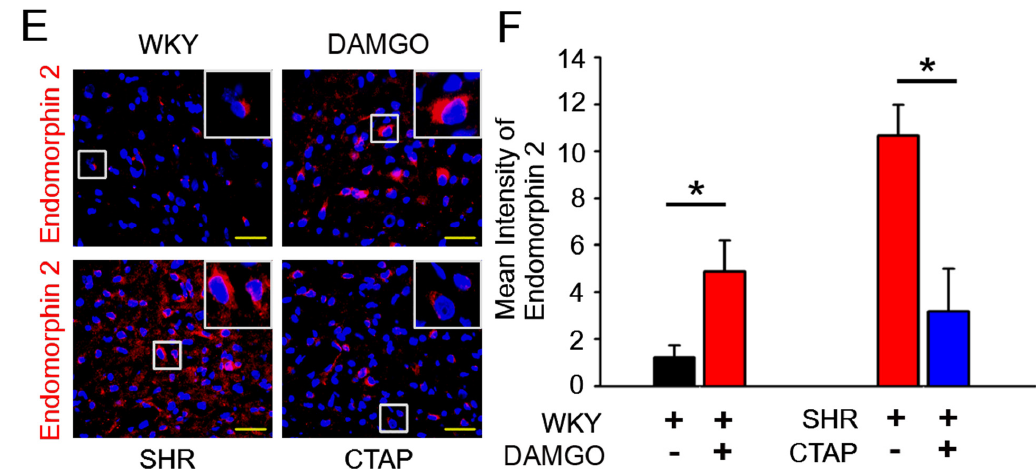
Figure 3. Activation of µ OR in the NTS and cardiovascular regulation of WKY rats and SHRs. ( A ) Representative tracings demonstrating the cardiovascular effects of [D-Ala 2 , MePhe 4 , Gly 5 -ol]-enkephalin (DAMGO) (0.3 nmol) injected into the unilateral NTS of anesthetized WKY ( ▲ time of injection). ( B ) Representative BP recordings of an intra-NTS microinjection of the μ OR antagonist CTAP in hypertensive SHRs ( ▲ time of injection). ( C ) Bar graphs showing the effects of 10-min treatment with DAMGO on the mean blood pressure (MBP) of anesthetized WKY. ( D ) Bar graphs showing the effects of 10-min treatment with DAMGO on the mean blood pressure (MBP) of anesthetized SHRs. ( E , F ) Representative red fluorescence images and the statistical analysis for Endomorphin-2-positive cells after DAMGO or CTAP treatment. The images were photographed at × 400 and 1000 magnification. The Mann–Whitney U-test was used for statistical analysis. Bar values are shown as mean ± SEM ( n = 6); * p < 0.05 versus control.